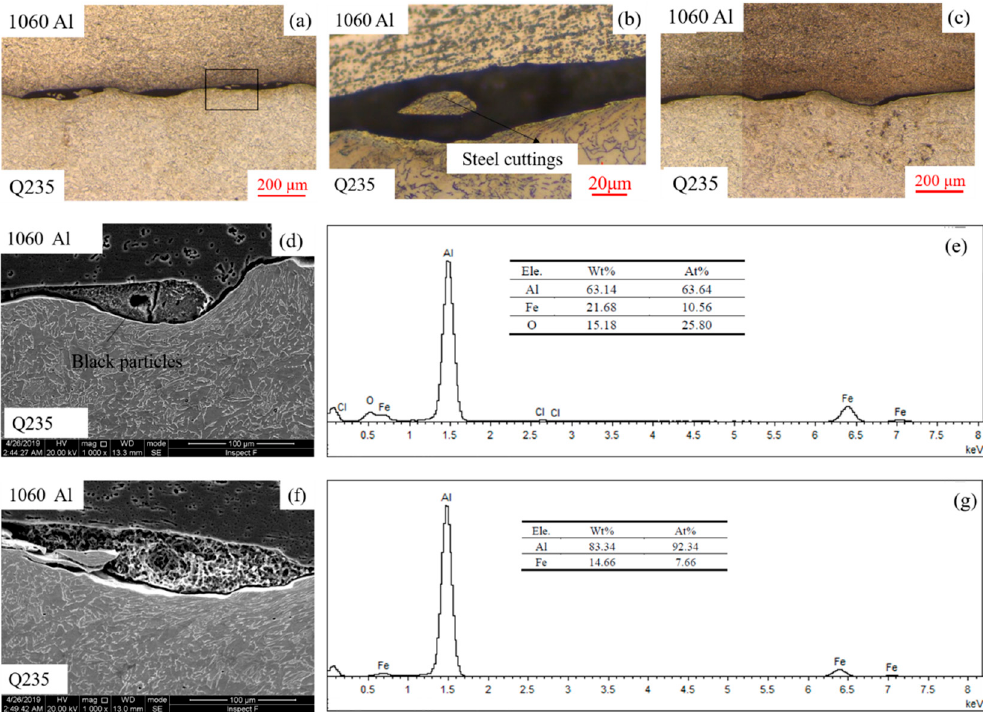
Figure 5. Comparisons between the unrepaired interface and the repaired interface: ( a ) and ( b ) unrepaired interface; ( c ) repaired interface; ( d ) and ( e ) Scanning Electron Microscope (SEM) and Energy Dispersive Spectroscopy (EDS) analysis of the unrepaired interface; ( f ) and ( g ) SEM and EDS analysis of the repaired interface.